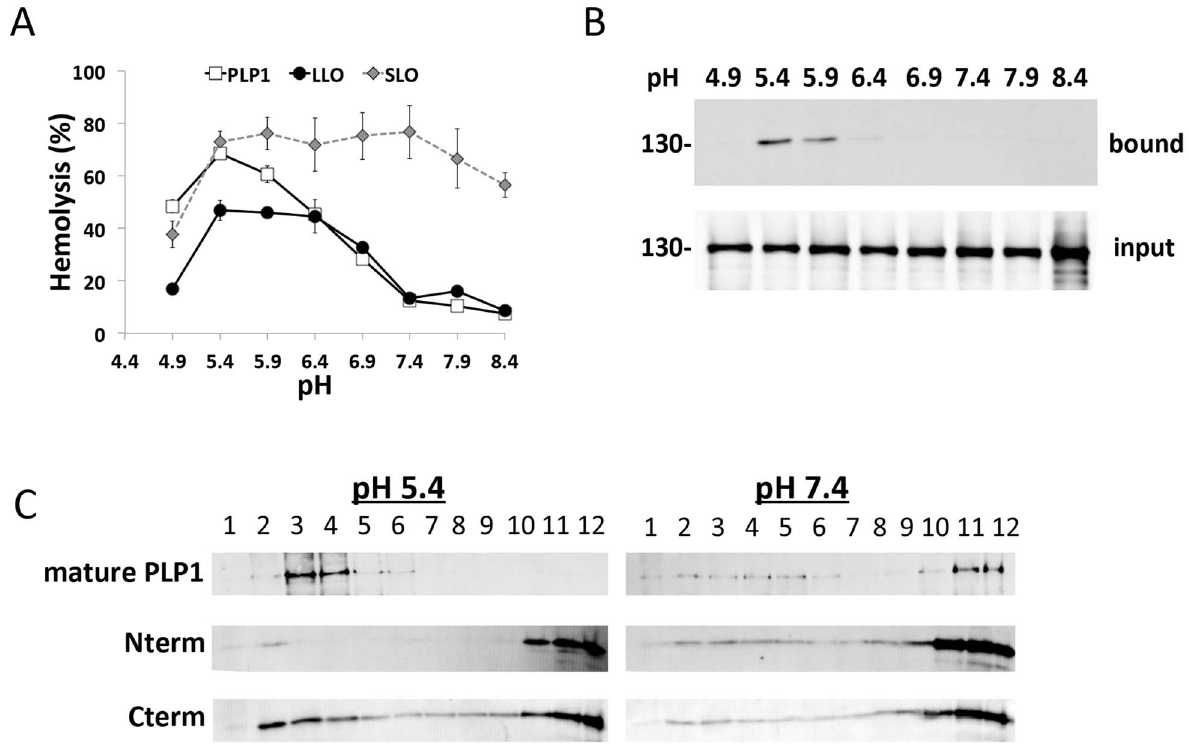
Figure 5. PLP1 displays pH-dependent lytic and membrane binding activity. (A) pH dependent hemolysis. 100 nM recombinant PLP1 or LLO or 2 IU SLO was incubated with sheep erythrocytes before measuring the 450 nm absorbance of the supernatant. Results indicate the average and standard deviation of triplicate wells and the graph is representative of 3 independent experiments. (B) PLP1 binding to membranes is pH dependent. Sheep erythrocyte ghosts were incubated with recombinant PLP1, washed with cold PBS, pelleted, and input and bound fractions were analyzed by immunoblot for PLP1. (C) PLP1 and its Cterm domain display pH dependent membrane binding measured by flotation during sucrose density centrifugation. Recombinant mature, Nterm, and Cterm PLP1 were incubated with sheep erythrocyte ghosts as for B, and the reaction mixture was subjected to sucrose density gradient membrane flotation. Fractions were collected from the top of the sucrose gradient and analyzed by immunoblot. Images are representative of 3 independent experiments.